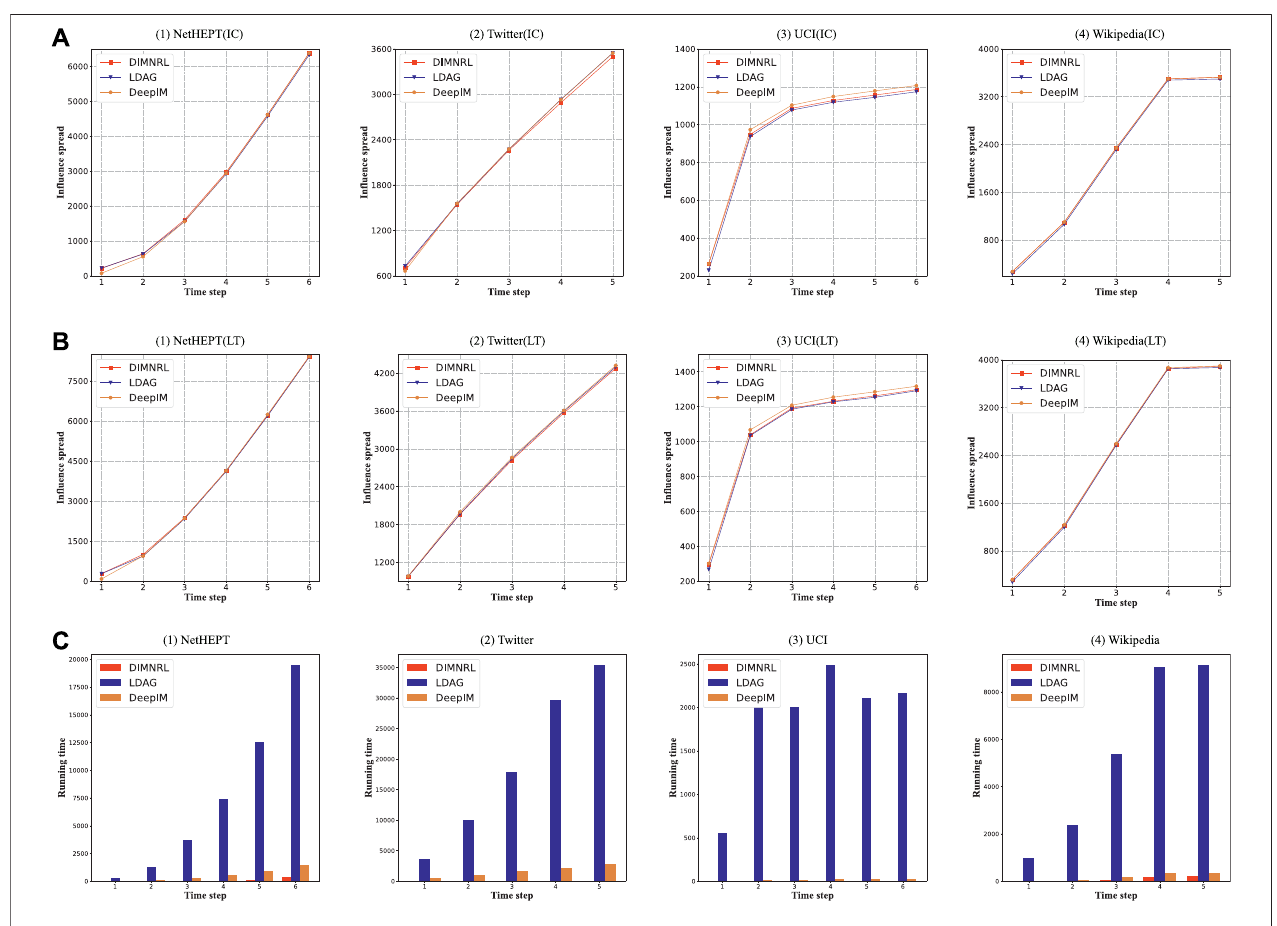
FIGURE 2 | Results of our experiments. (A) In fl uence coverage of different algorithms on four datasets under the IC model, (B) in fl uence coverage of different algorithms on four datasets under the LT model, and (C) running time of three algorithms on four social network datasets.